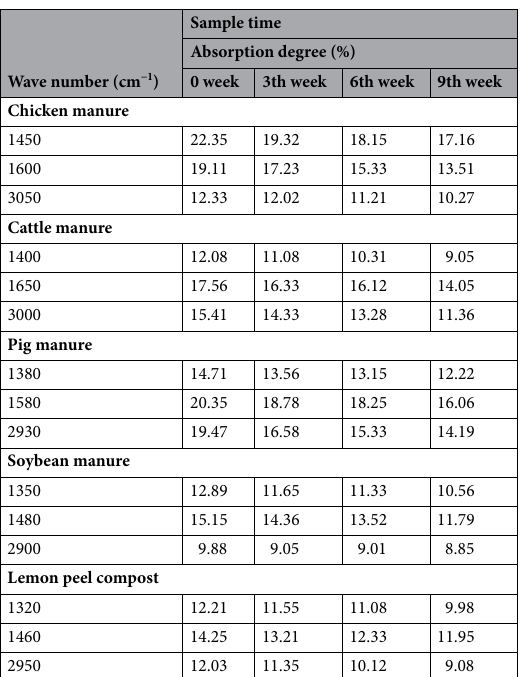
Table 6. The absorption of FTIR spectroscopy of main wave number at the sampling stage of different manures.